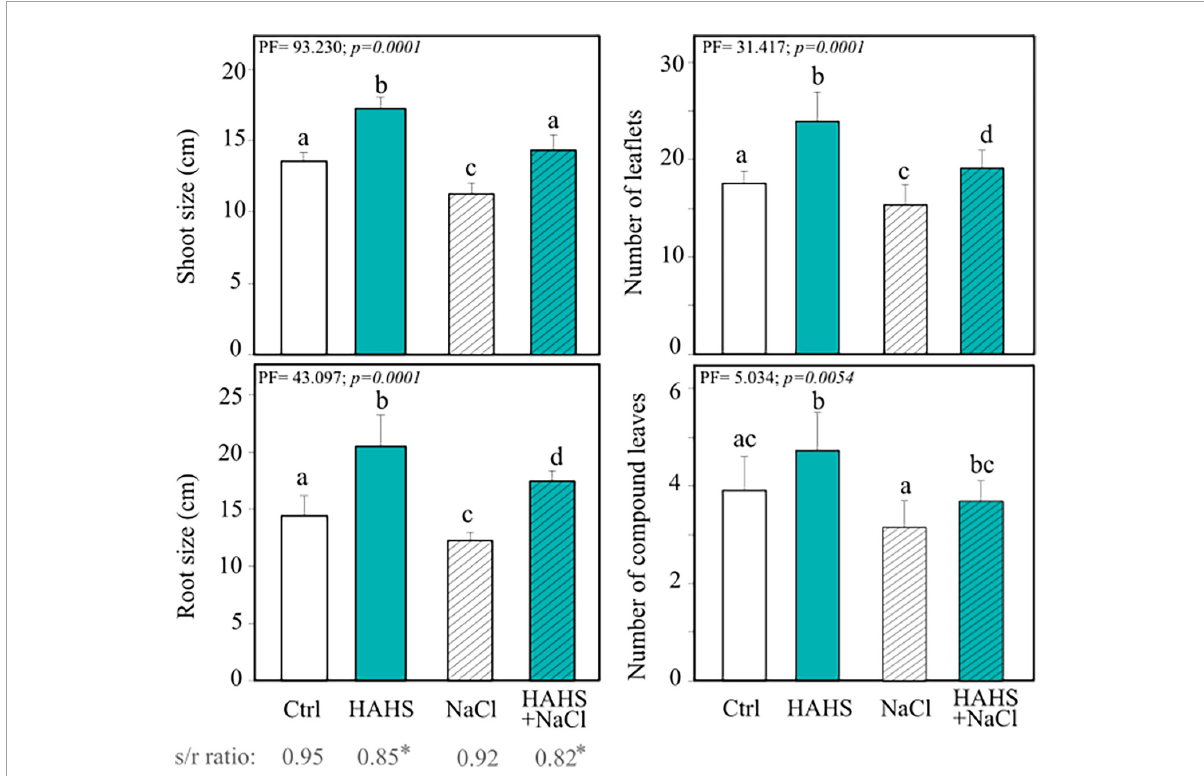
FIGURE4 Salinispora arenicola enhances the growth of tomato plants under normal and salt stress conditions. Phenotype measurements of 39 DAG plants grown with either NaCl-free irrigation or saline irrigation that were either inoculated with a habitat-adapted heterologous symbiont (HAHS) bacterium or not (control; Ctrl). Statistical significance was determined using a permutational ANOVA (PERMANOVA; p = 0.001 ). Lowercase letters denote statistical differences (pairwise test) among